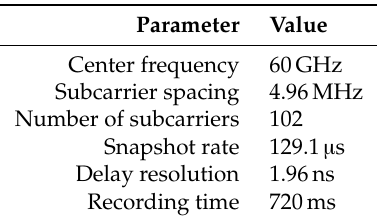
Table 2. Channel sounding measurement parameters. For the full parameter set, refer to [28].